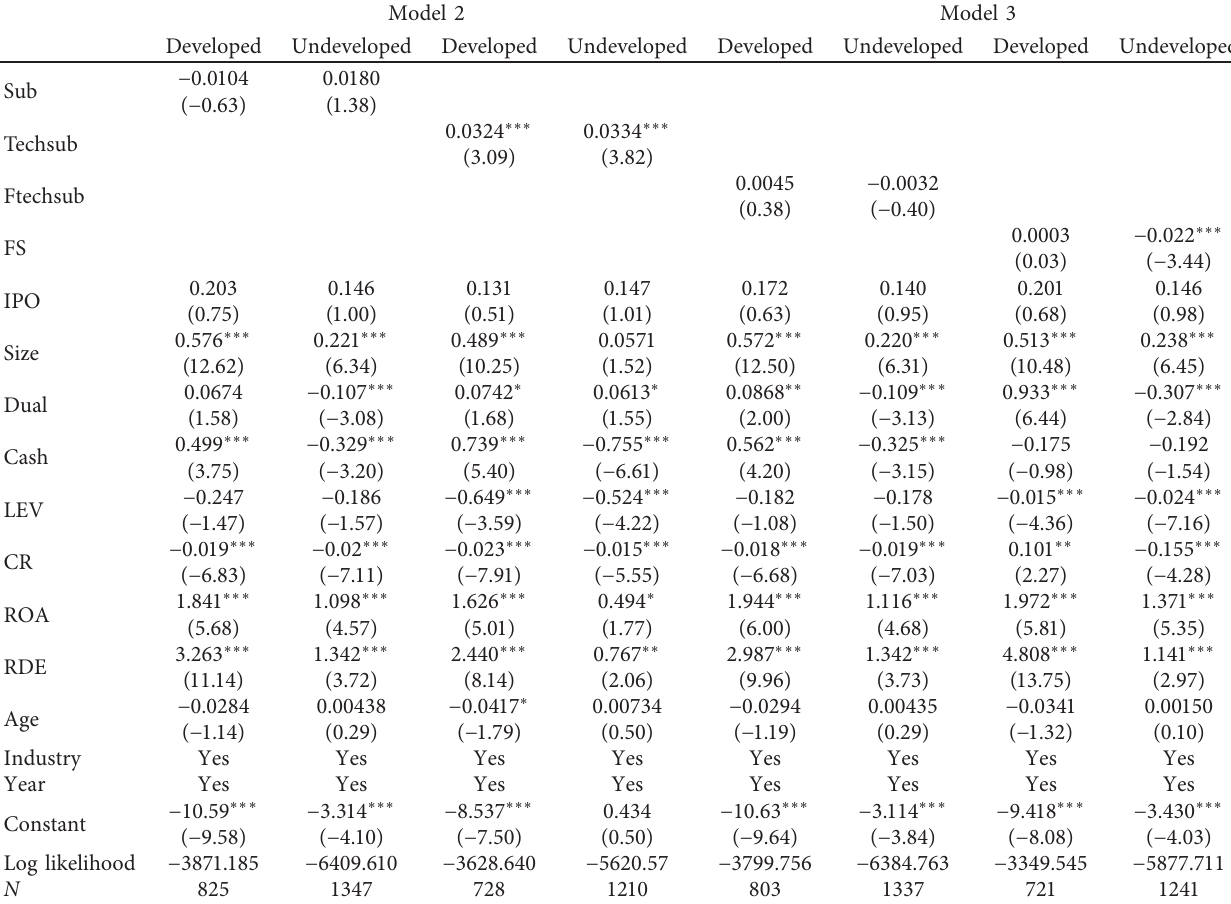
Table 6: Grouping study of regional characteristics.